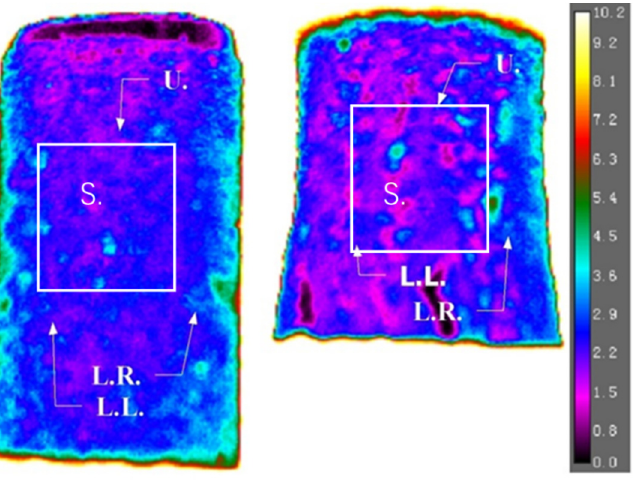
Figure 9. Temperature profile of frozen sand specimen at the start ( right ) and end ( left ) of the compression test (unit of scale bar is in °C).